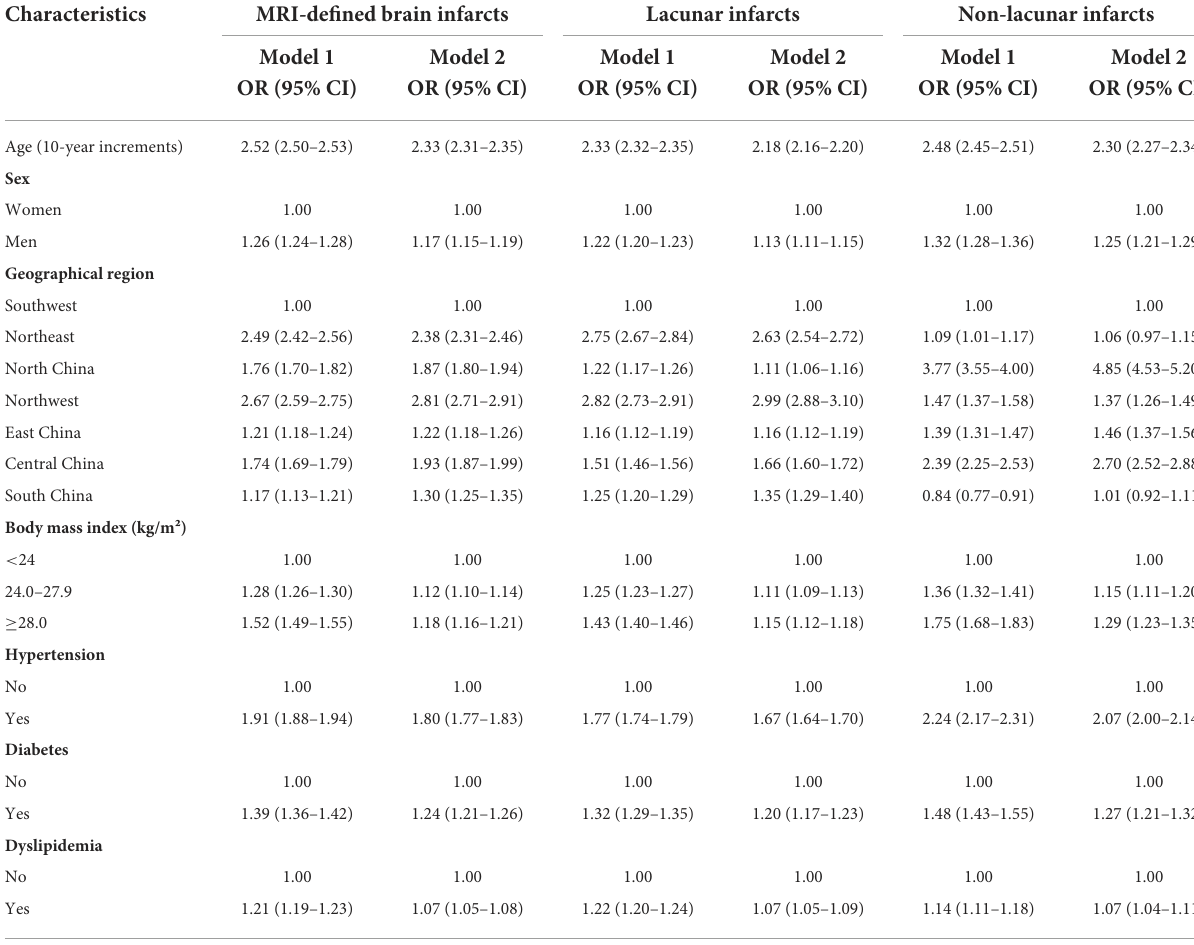
TABLE 3 Multivariable adjusted odds ratios of MRI-defined brain infarcts in the Chinese health examination population in 2018.